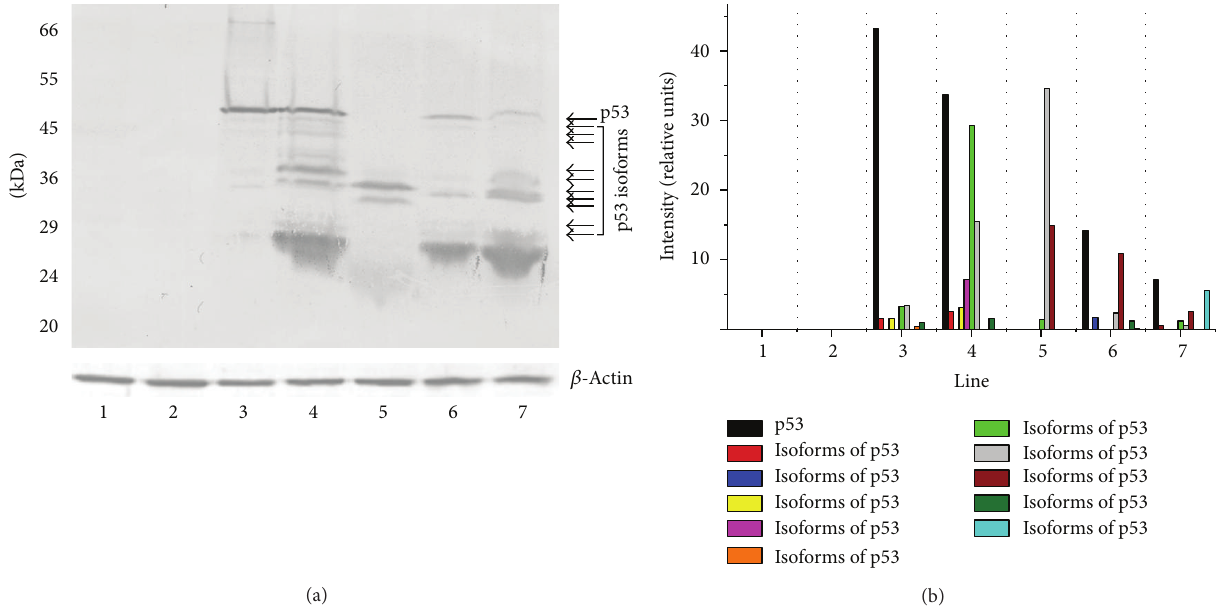
Figure 6: (a) Western blot analysis of p53 expressed in the nuclear fraction of human breast cancer cells revealed a wide spectrum of isoforms (49, 48, 47, 45, 36, 35, 34, 29, 28, and 24 kDa). These isoforms were not present in nontransformed cells (control cases, lines 1 and 2). Only the Δ 133p53 𝛽 (35 kDa) and ∼ 36kDa isoforms are present at higher levels in the invasive breast carcinomas (lines 4, 5, and 7) compared to noninvasive cases (lines 3 and 6). The analysis suggested coexpression of mutant forms of p53 and/or wild-type p53 with p53 isoforms indicated. Expression of multiple p53 isoforms varied between phenotypically distinct subset of cases. In normal breast tissues, expression of p53 is either very low or not measurable. Equal amounts of nuclear proteins (50 𝜇 g/lane) from extracts of normal and breast cancer tissues were separated on 12% SDS-PAGE and transferred to nitrocellulose membrane. Incubation with CM-1 rabbit polyclonal antibody (diluted 1:1000) was followed by incubation with biotinylated swine anti-rabbit Ig serum (diluted 1:1000) and strept ABComplex-HRP conjugated as described in Section 2. HRP was detected with DAB as chromogen. Bottom panel shows actin loading control. All Western immunoblotting experiments were performed at least twice with similar results. Lines 1 and 2—normal breast tissue. Lines 4, 5, and 7—invasive ductal breast carcinomas. Lines 3 and 6—noninvasive breast carcinomas. Molecular mass markers are presented on the left (MW). The position of the p53 is indicated by the arrow. The arrows denote the position of the p53 isoforms. (b) Relative abundance of p53 and its isoforms in the nuclear fraction of breast cancer cells. The levels of p53 and its isoforms in each sample were quantified using transmission scanning and analyzed by Gel-Pro Analyzer 3.1. Significant increase of the p53 and its isoforms (35 and 36kDa) is evident in nuclear fraction of breast cancer